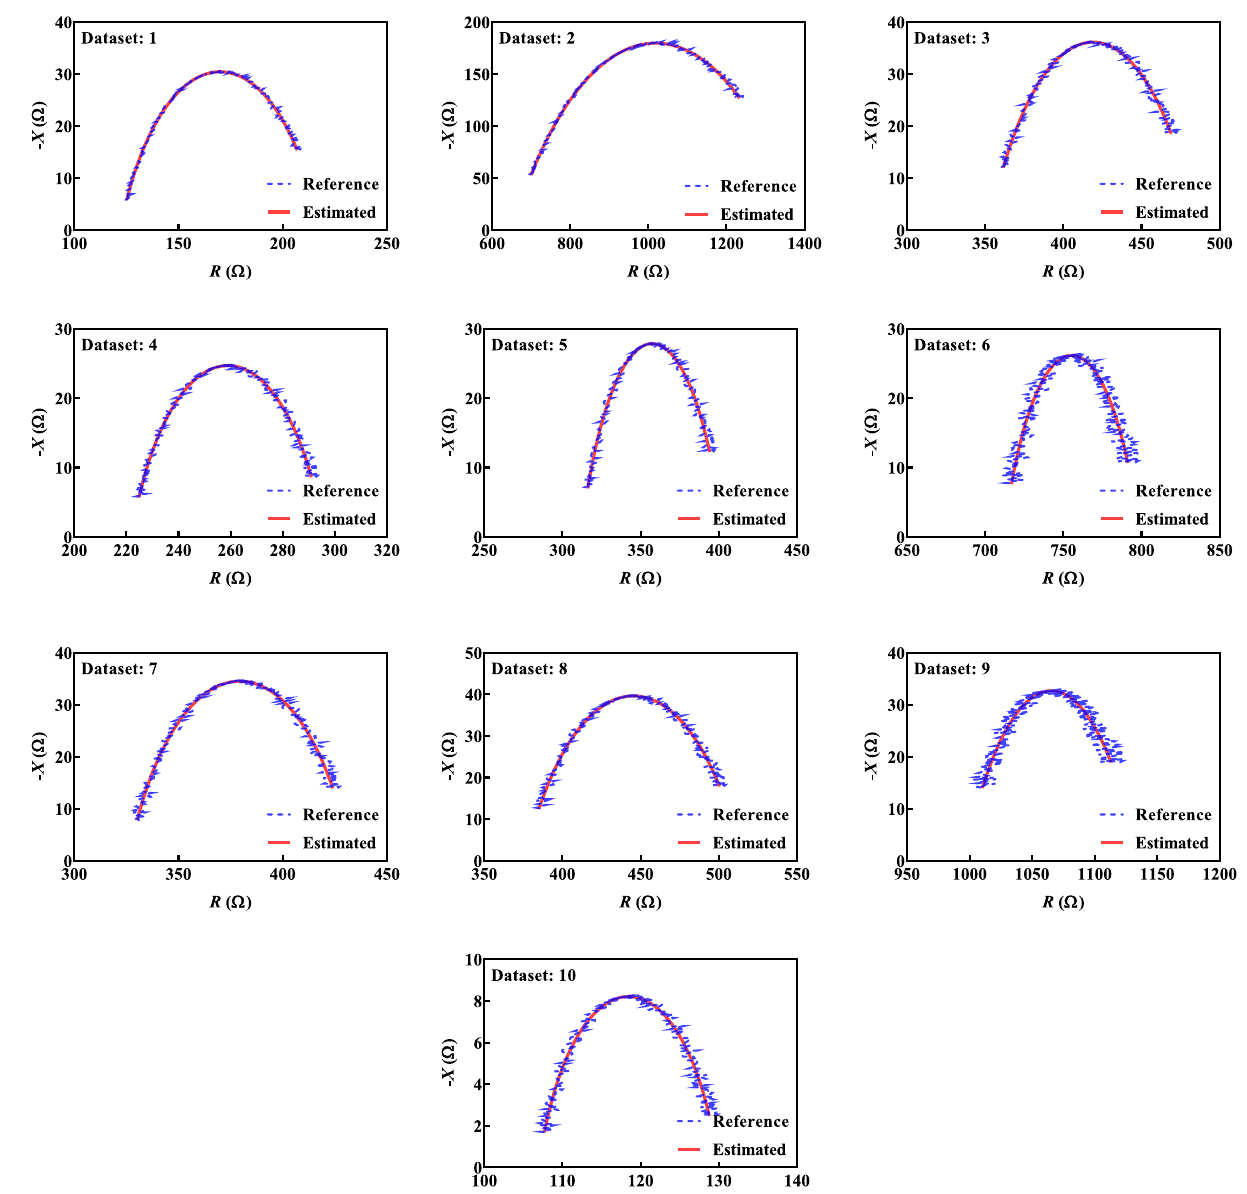
Figure 2. The Nyquist plots of reference and estimated